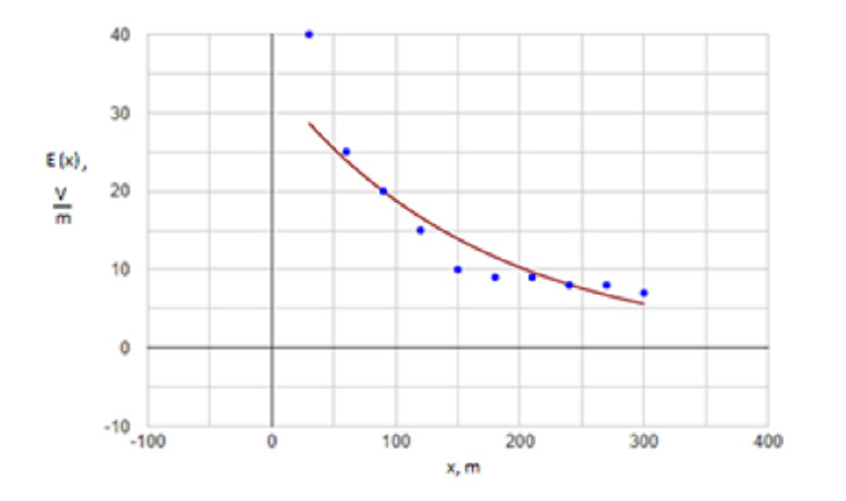
Fig. 8. Dependence of signal amplitude on the distance between the antennas. Signal frequency is 10 MHz